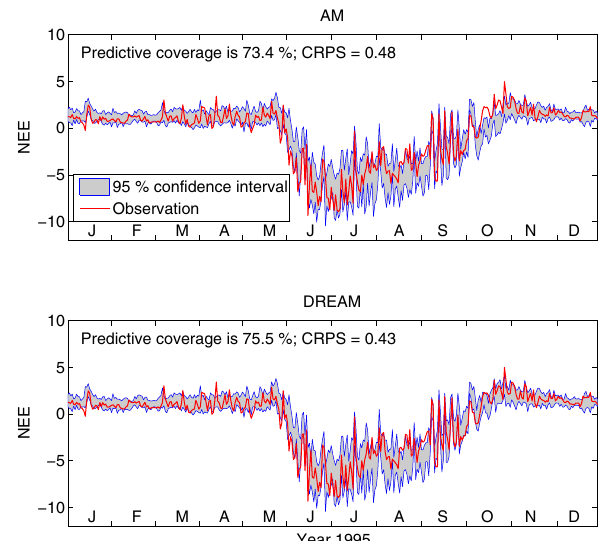
Figure 8. 95% confidence intervals of the simulated NEE values in year 1995 based on the parameter samples from AM and DREAM. Two measures of predictive performance, CRPS statistic and predic- tive coverage, indicate that DREAM outperforms AM in